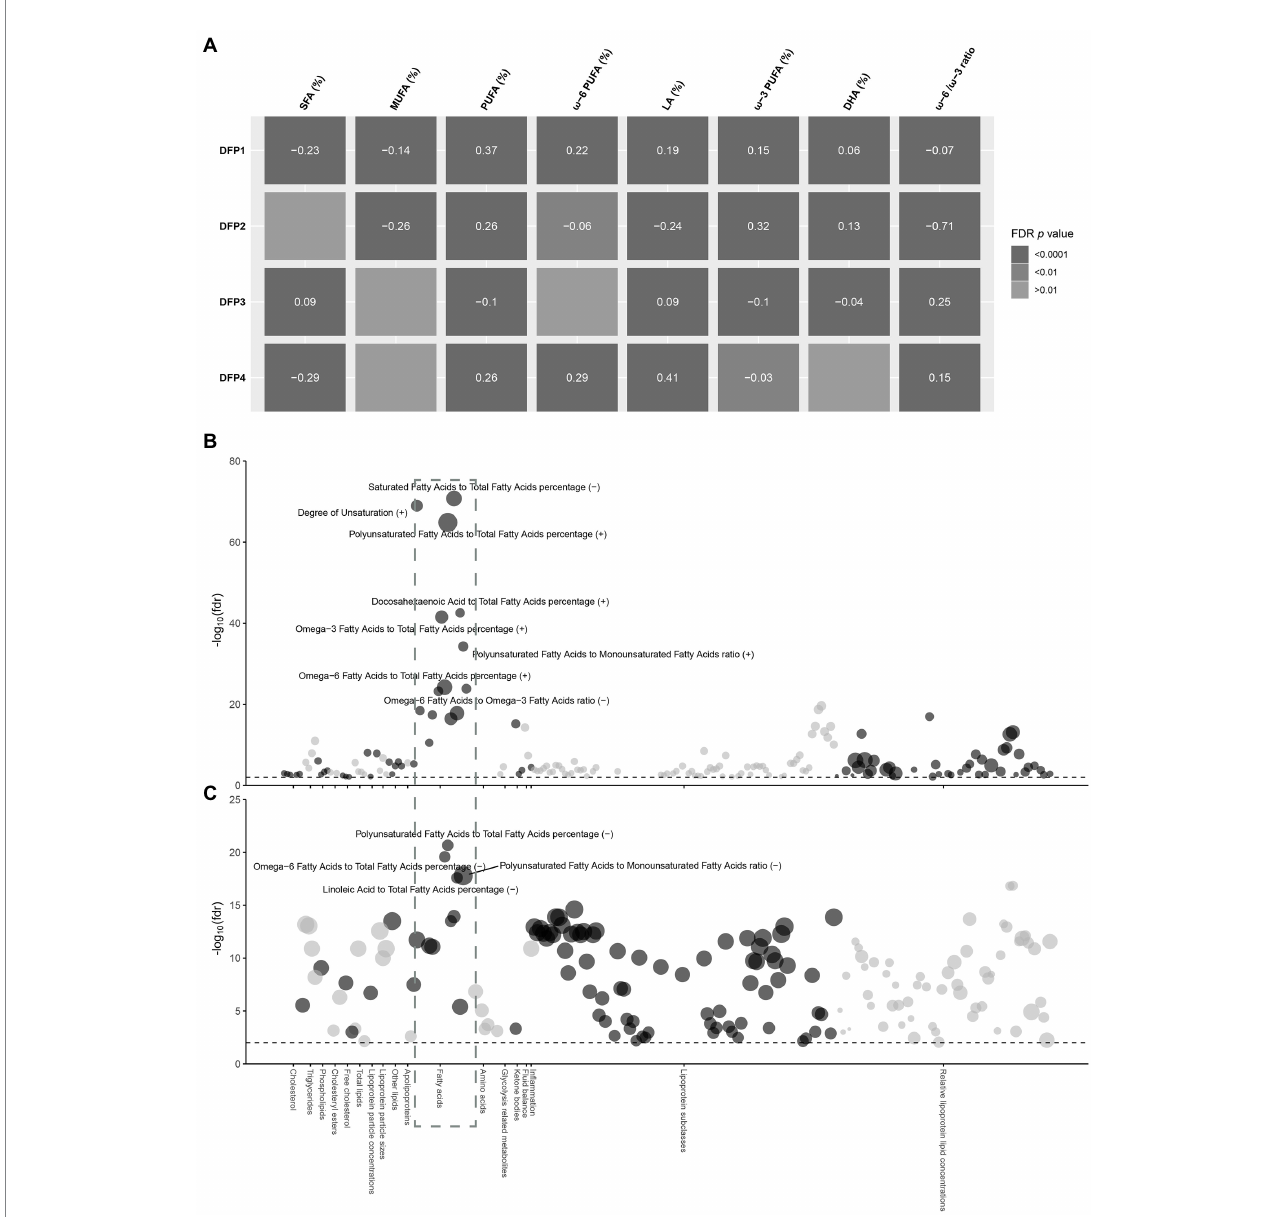
FIGURE 3 Observational association between DFP1 and NAFLD with serum metabolic biomarkers. (A) Heat map of the correlation between DFPs and serum fatty acids. Colors indicate FDR p values, the values in the center of the color blocks represent effect sizes, and the positive and negative represent the direction of the effect. (B) Observational association between DFP1 with serum metabolic biomarkers. (C) Observational association between NAFLD with serum metabolic biomarkers. The radial axis is the significance of association in − log 10 (FDR p ), and the black dashed line represents the significance level FDR p < 0.01. The size of the point represents the size of the effect value, and the positive and negative represent the direction of the